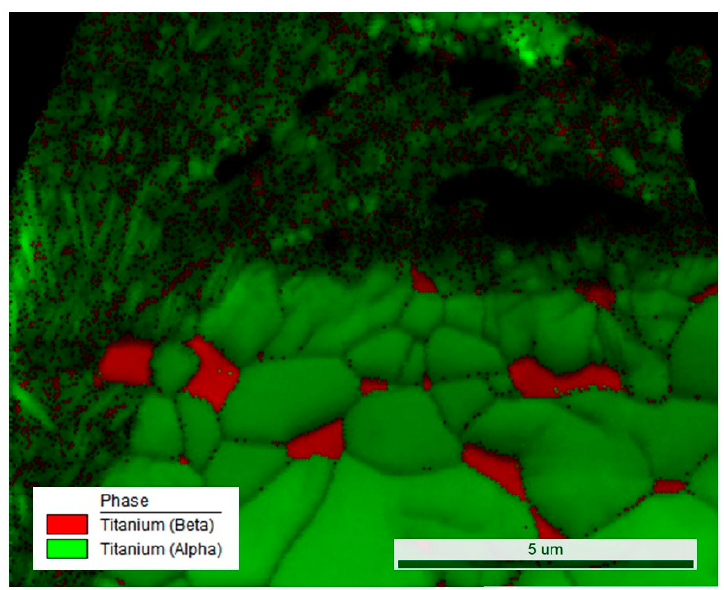
Figure 2. SEM micrograph of a laser channel obtained by the secondary detector. The black square marks the location of EBSD as shown in Figure 3.